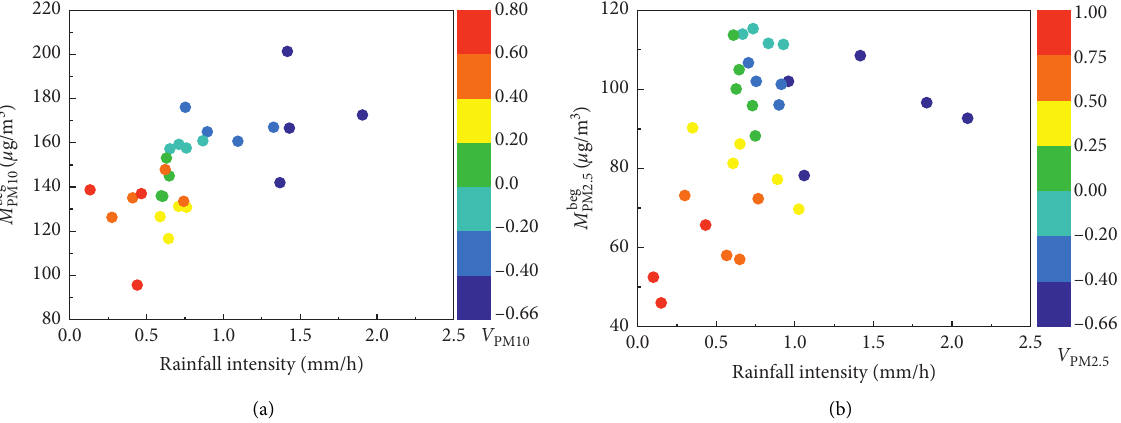
Figure 6: The distributions of average M beg 0.05: (a) PM 2.5 ; (b) PM 10 .